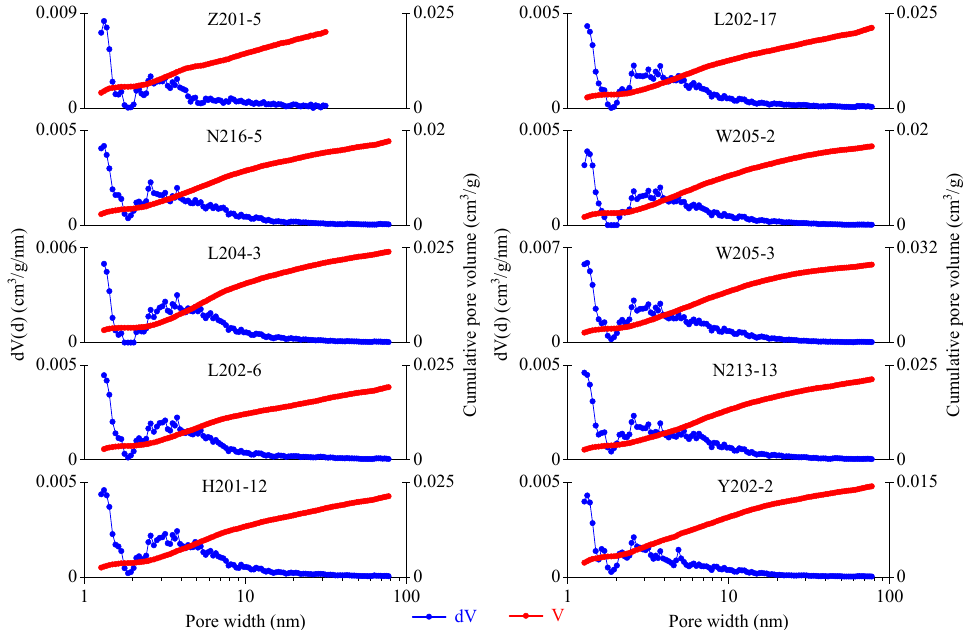
Figure 10. Pore size distribution curves from low ‐ pressure N 2 adsorption ‐ desorption experiment.